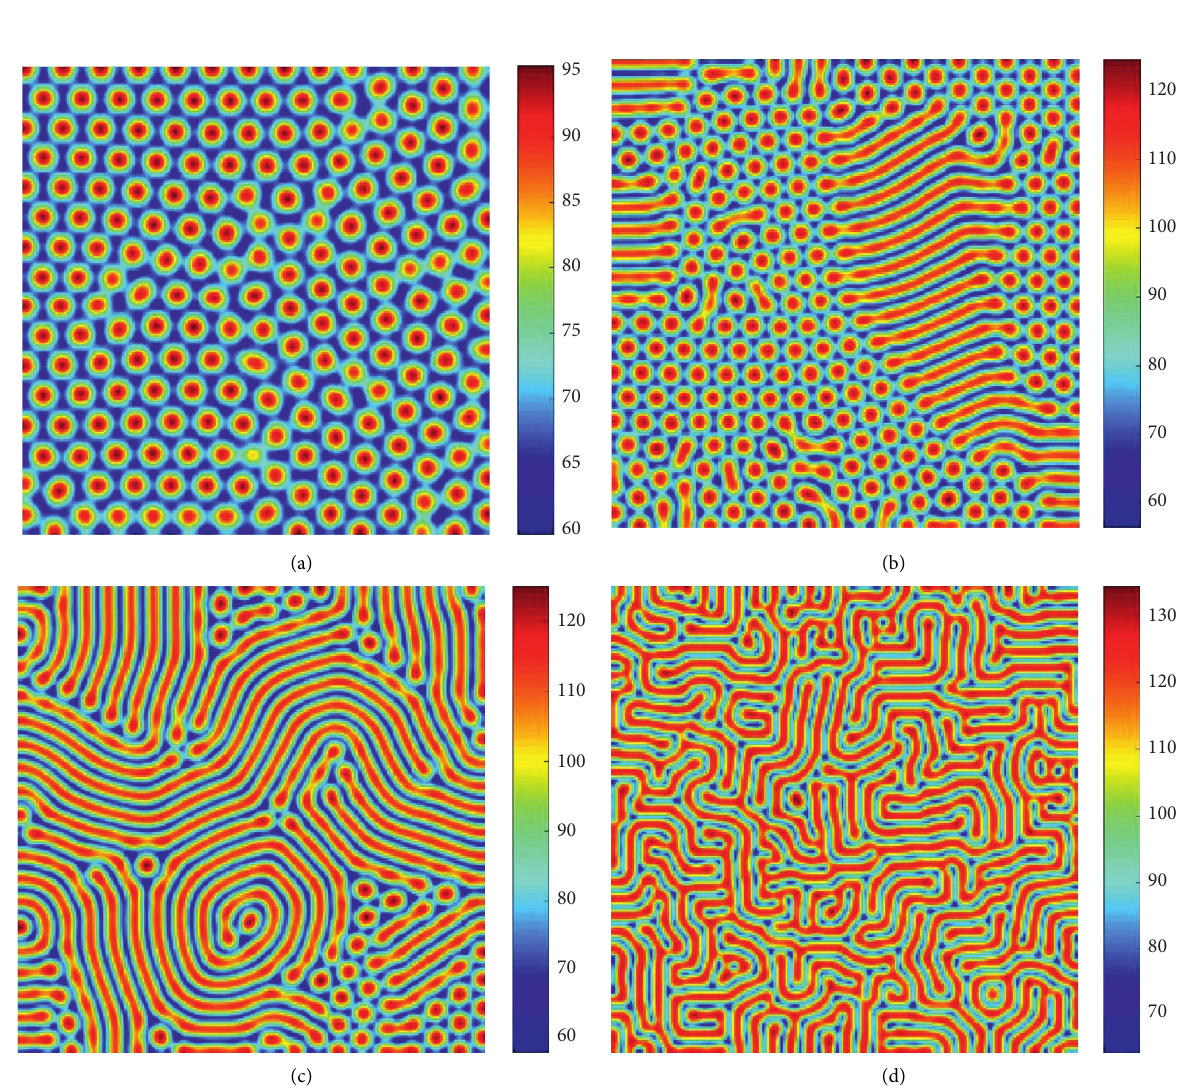
Figure 3: The spatial patterns of the predator with different values of 31: (a) 31 � 0.95; (b) 31 � 0.5; (c) 31 � 0.47; (d) 31 �